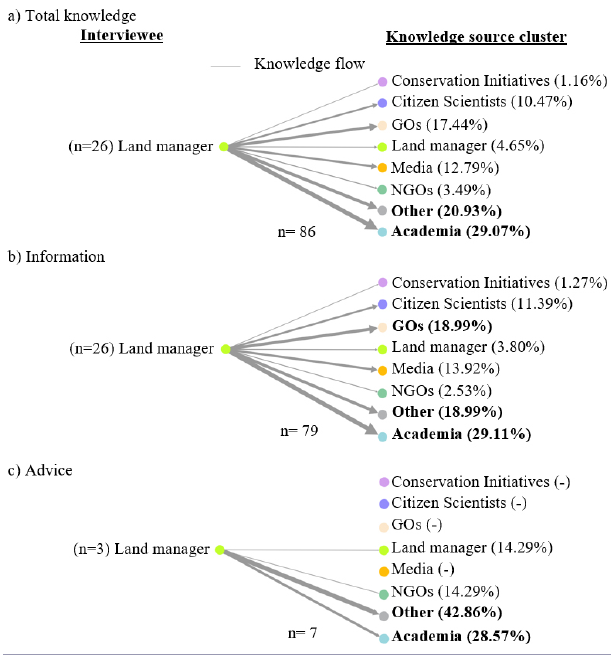
Fig. 4. Flow charts of the proportional knowledge provision in the different clusters containing land managers. (A) Overall knowledge sharing, (B) information sharing, and (C) advice sharing. Percentages in parentheses indicate the share of knowledge from each source cluster. Lines illustrate knowledge exchange, line thickness indicates the number of times a knowledge source cluster was mentioned, arrows point to the cluster that was named, and numbers beneath give the total number of links.